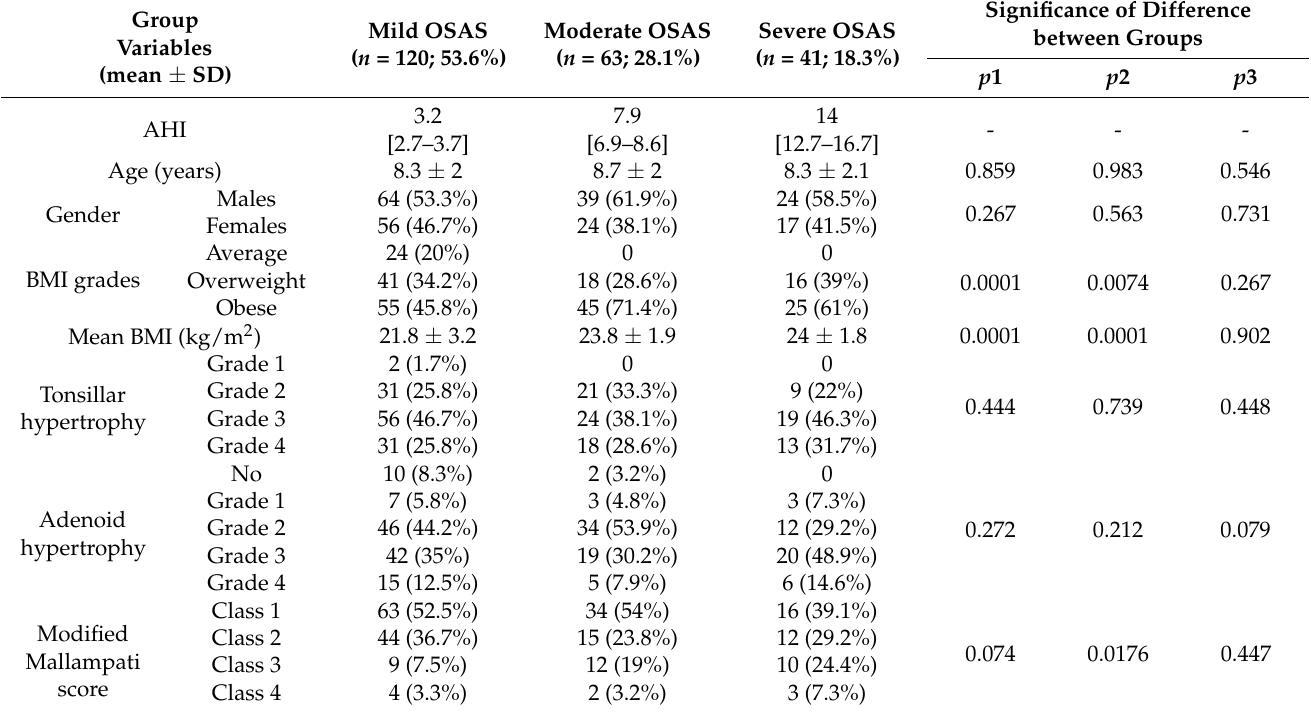
Table 1. Demographic and clinical data studied patients who were categorized at the time of enrolment according to the estimated AIH score.